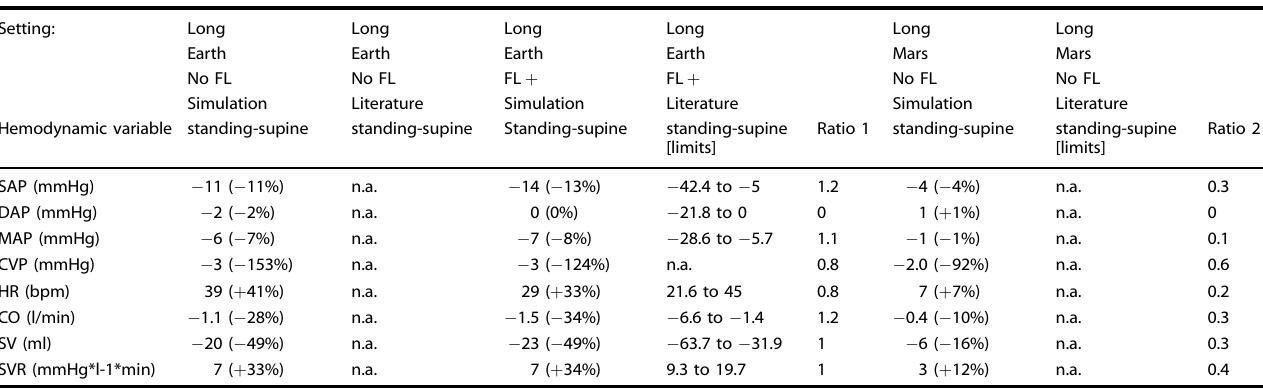
Table 2. Hemodynamic changes to an orthostatic stress test on Earth and Mars after a long-duration space fl ight.